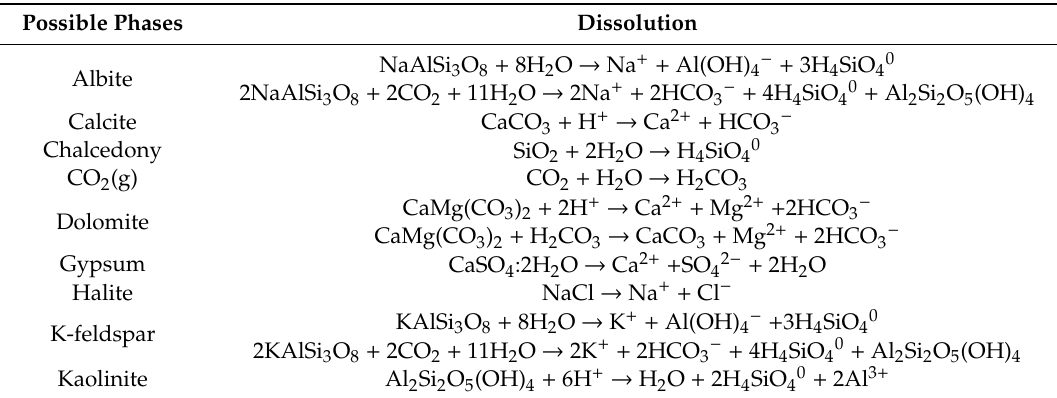
Table 6. Mineral dissolution